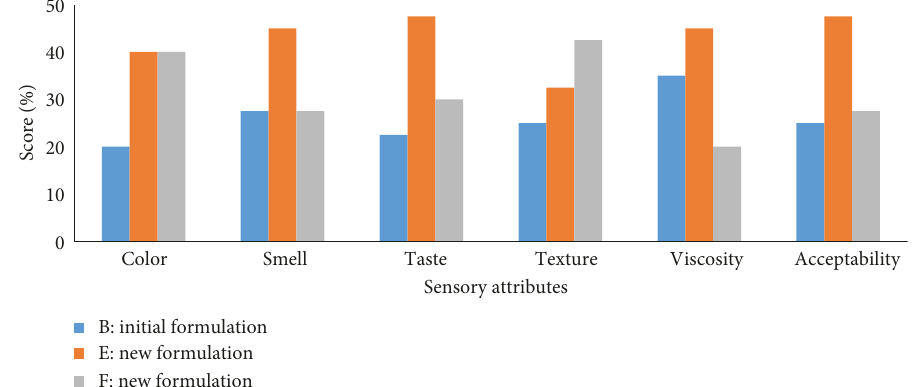
Figure 2: Preference ranking (%) of different Kapkerer’s children porridge against different sensory attributes.